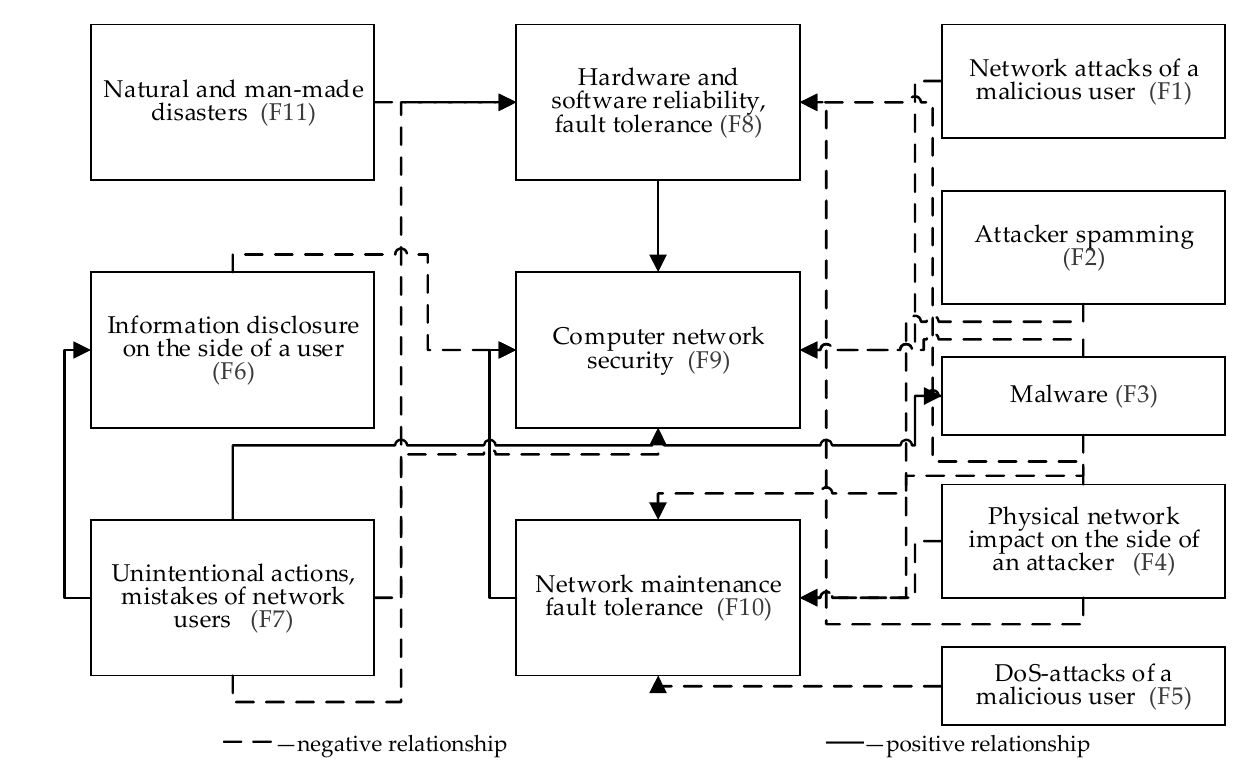
Figure 1. Fuzzy cognitive map of the state of bank cybersecurity. Table 1. Contiguity matrix of fuzzy cognitive map of bank